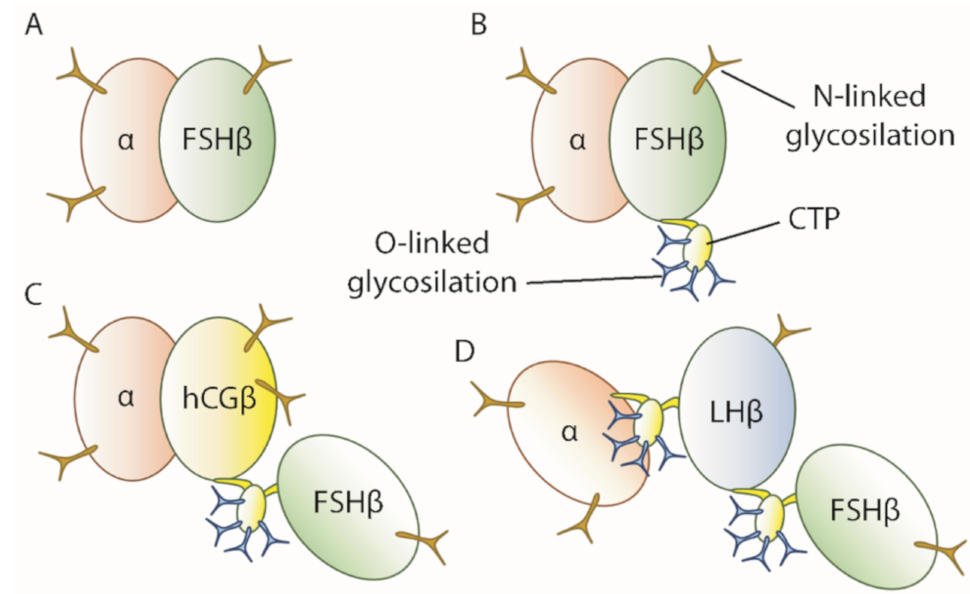
Figure 2. Schematic representation of FSH, FSH-CTP, and of the FSH β -CTP-CG β - α and FSH β -CTP-LH β -CTP- α analogues; ( A ) FSH molecule; ( B ) FSH-CTP with four additional O-linked glycosylations; ( C ) dually active FSH β -CTP-CG β - α analogue. ( D ) dually active FSH β -CTP-LH β -CTP- α